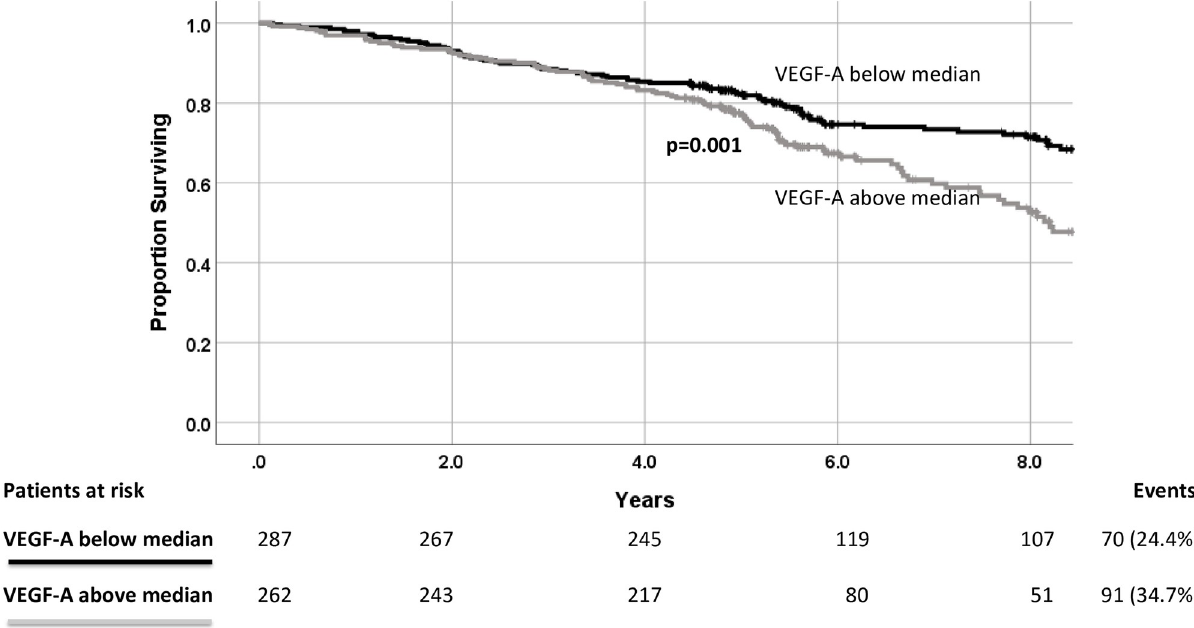
Fig 1. Kaplan-Meier survival plot for survival versus all-cause death in the CDCS cohort stratified by above and below median baseline VEGF-A levels.